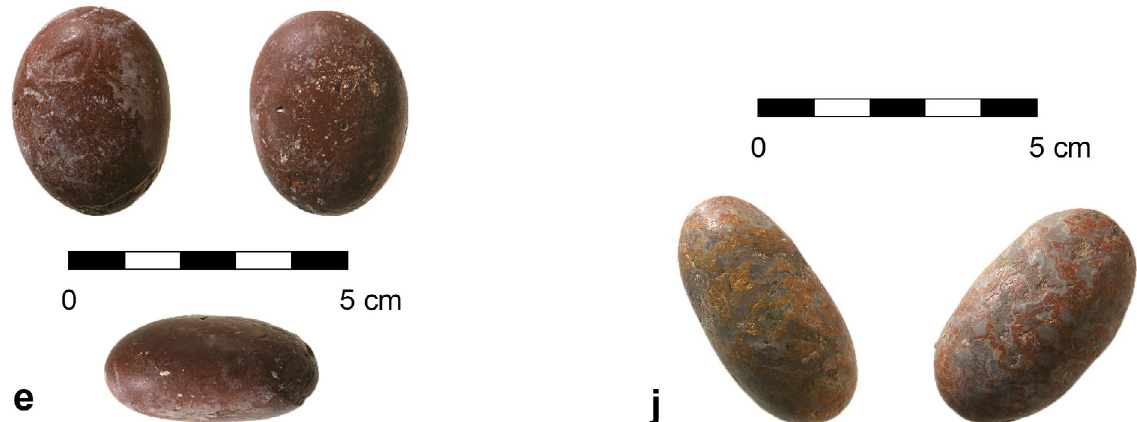
Figure 7. A close-up look at items of the "light"